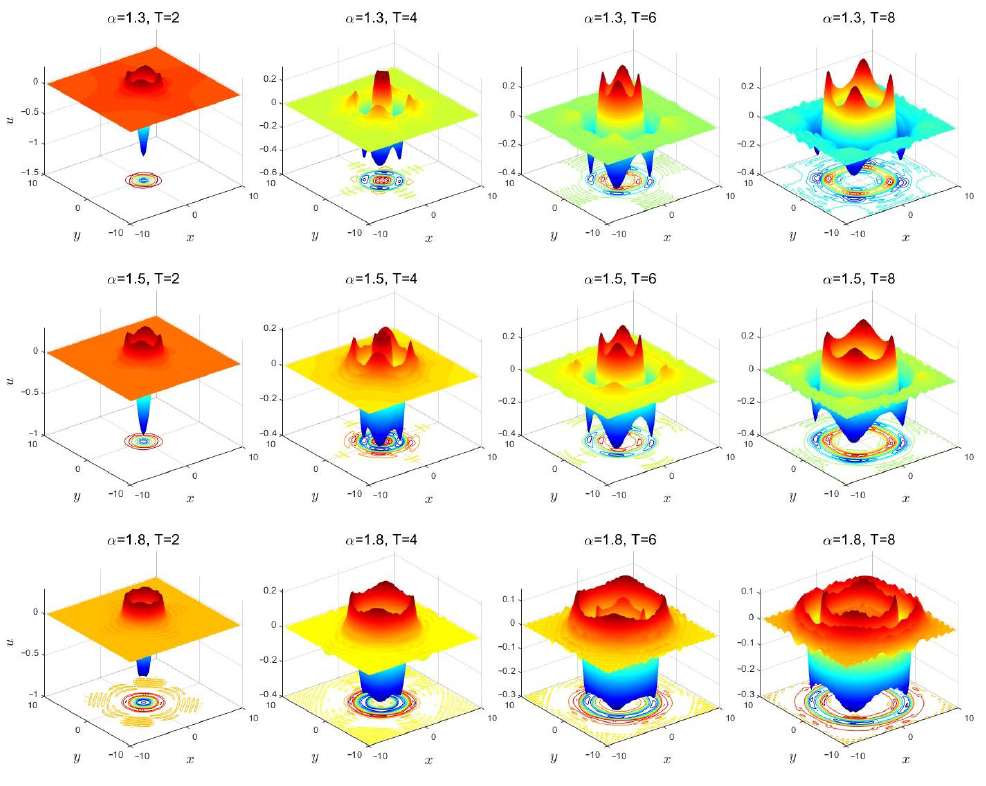
Figure 5. Surfaces of the numerical solutions and contour of Example 4 at time T with h x = h y = 1/4, τ = 1/16 for γ = 0 and different α .